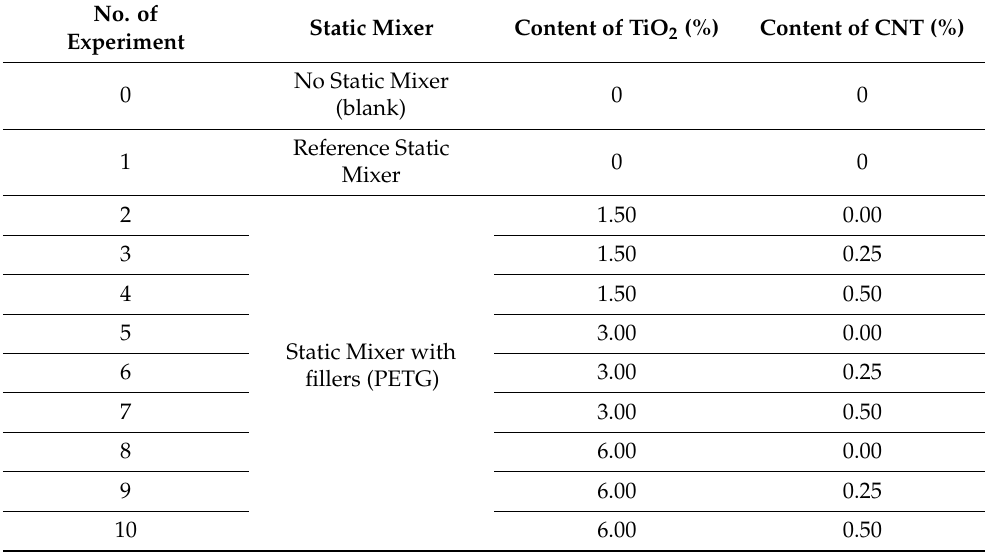
Table 2. Static mixers which were used for experiments of solar photocatalysis.